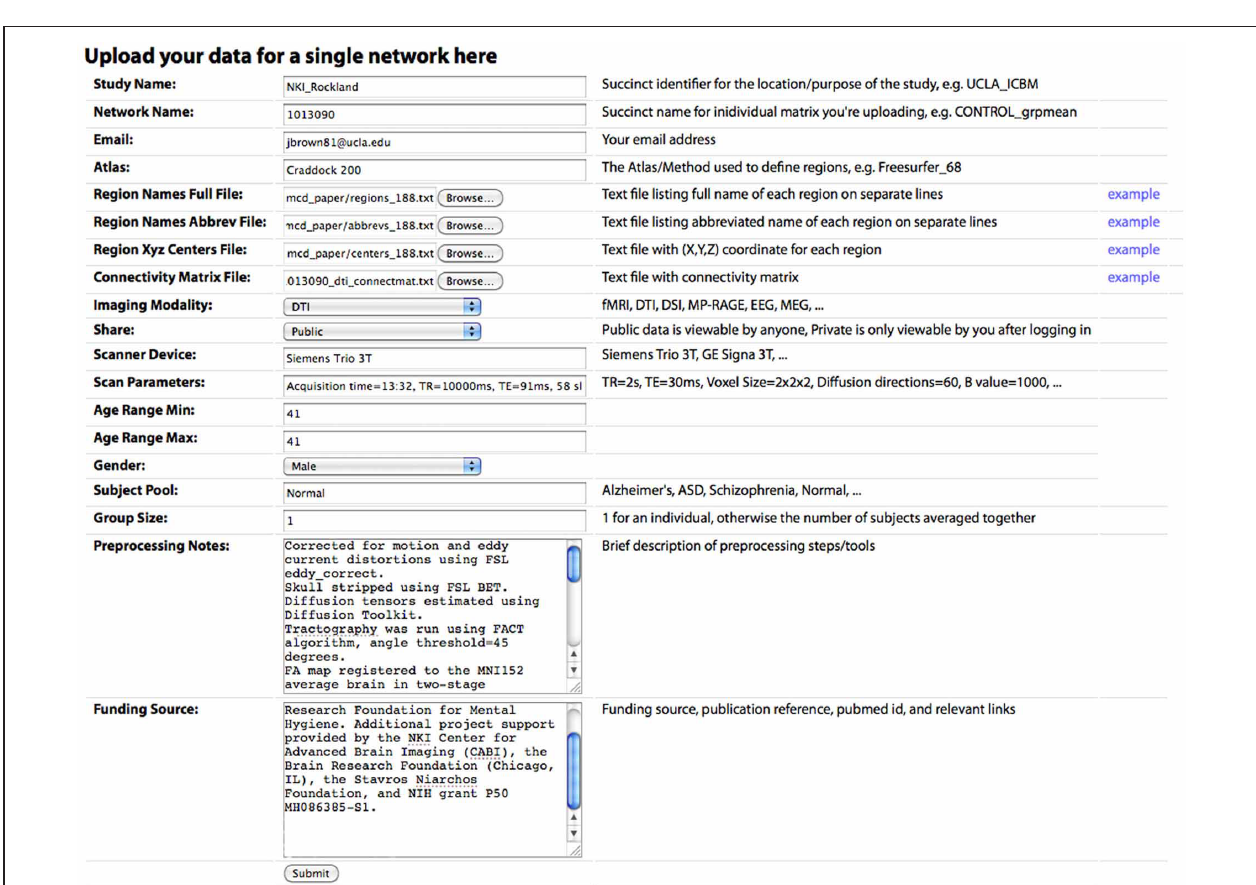
FIGURE 3 | The “Upload New Data” page, where a user can upload a CM. Descriptions of each field are included in the main